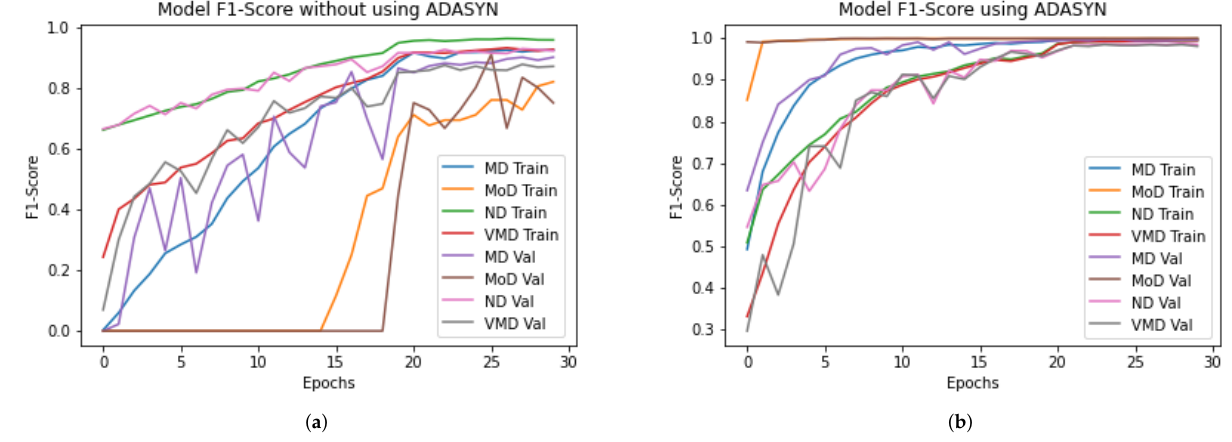
Figure 11. Self-comparison of F1-score of proposed DAD-Net With and without using ADASYN up- sampling algorithm. ( a ) Proposed DAD-Net without ADASYN; ( b ) Proposed DAD-Net with